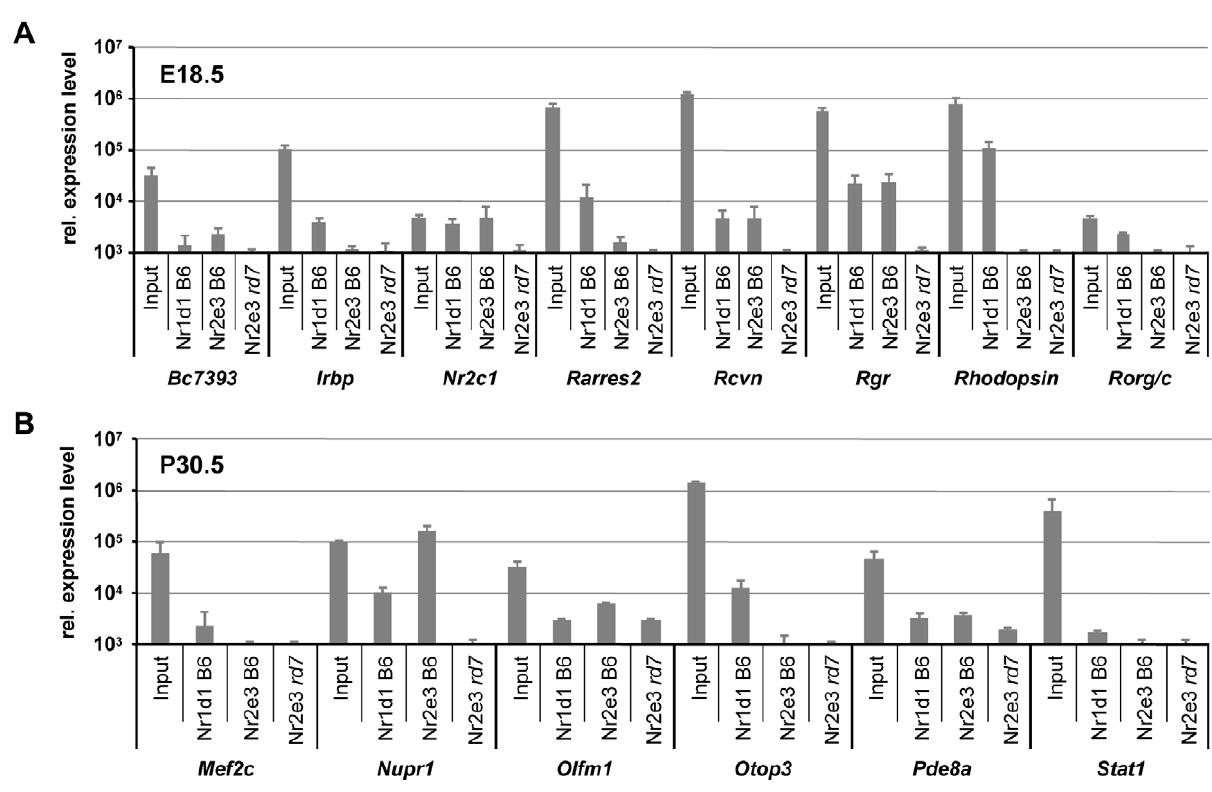
Figure 6. In vivo identification of gene targets by NR1D1 and NR2E3 in the developing and adult retina. Chromatin immunoprecipitation was conducted with Nr1d1 and Nr2e3 antibody in the developing (embryonic day 18.5) and adult (postnatal day 30.5) retina and analyzed by quantitative RT-PCR. Samples were normalized to immunoglobulin (Ig) control precipitation. X axis: expression relative to Ig. Input: positive control, Nr1d1 B6: NR1D1 ChIP in B6 retina, Nr2e3 B6: NR2E3 ChIP in B6 retina, Rd7: NR2E3 ChIP in rd7 retina (negative control). n=3. Data values normalized with reference to chart axis.